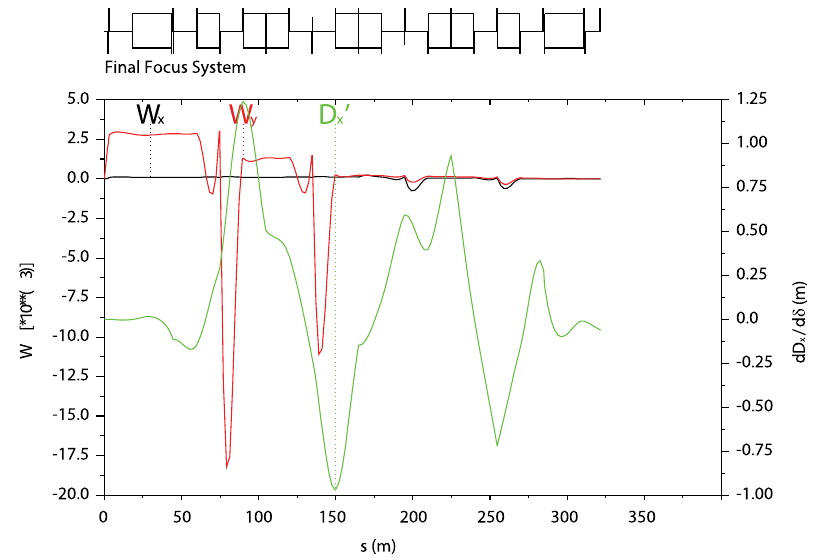
FIG. 13. W function and the second-order dispersion in the final focusing system with the local chromatic compensation.